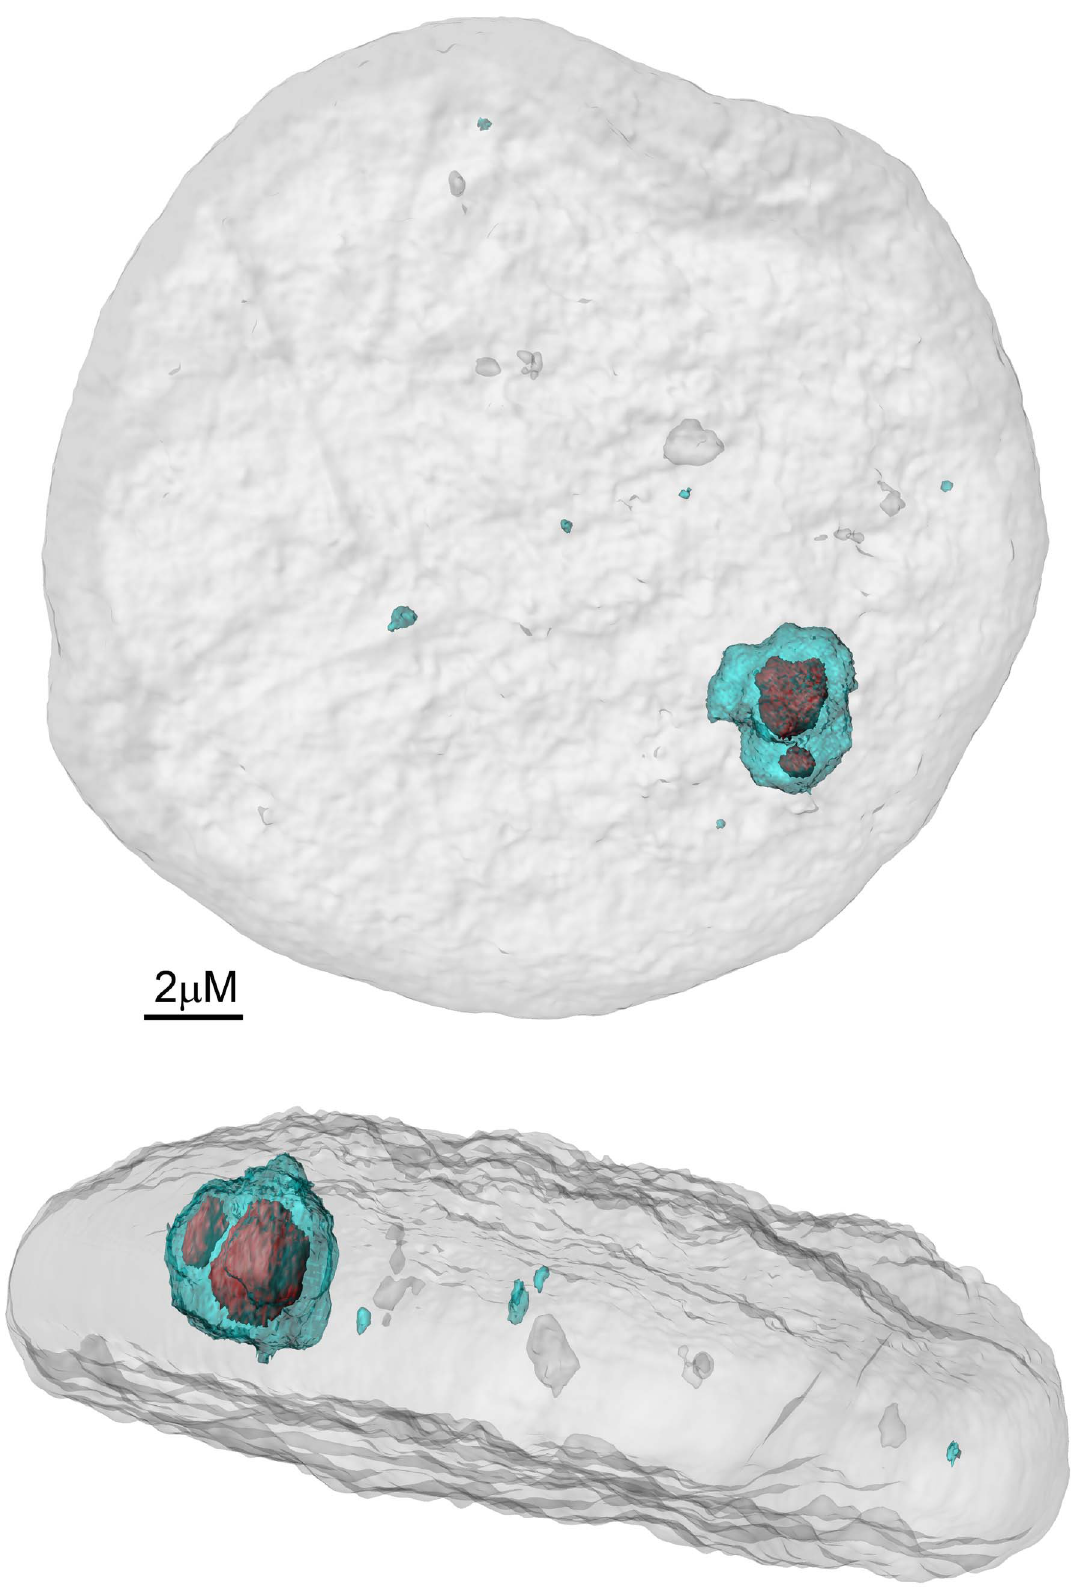
Figure 2. CIN612-9E cells were derived from a cervical lesion and contain hundreds of copies of extrachromosomally replicating HPV31 genomes [ 52 ] . These cells can be induced to differentiate with high calcium–containing medium, which switches on vegetative viral DNA replication [3]. Many of these cells contain multiple small replication foci [3,4]; but numerous cells contain one large foci, as shown here, perhaps